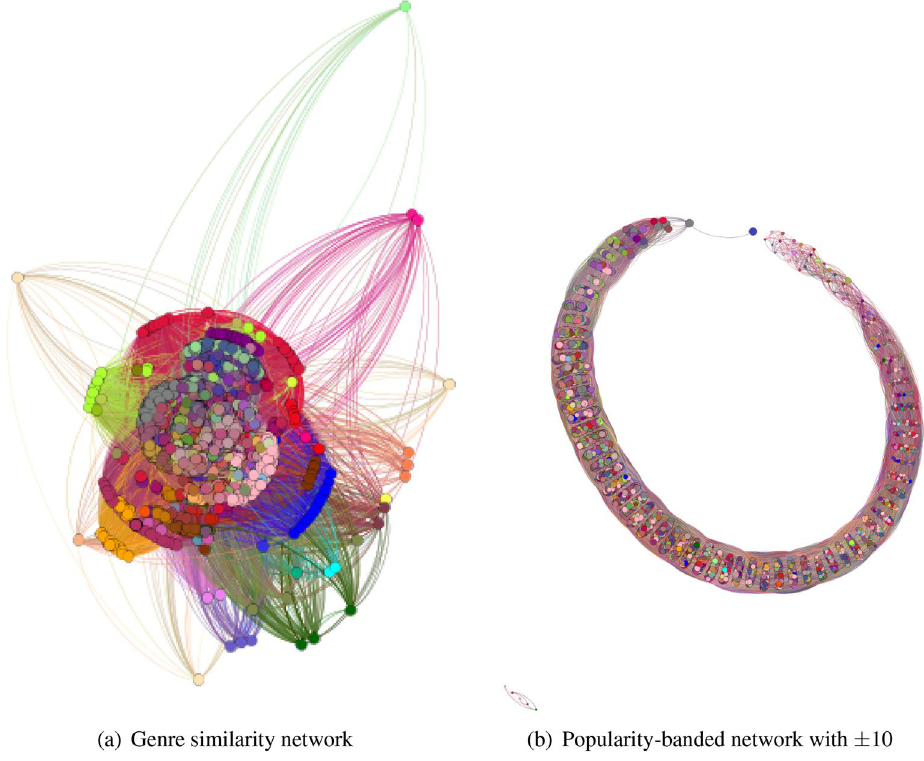
Figure 8. ( a ) Genre Similarity and ( b ) Popularity-banded Networks for genre-musician relation analysis.